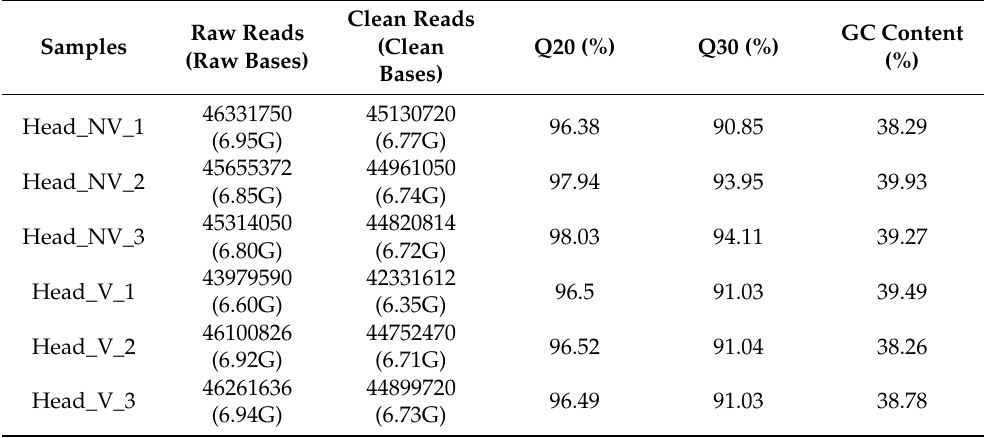
Table 1. Summary of the transcriptome sequencing data from the viruliferous and non-viruliferous SBPH